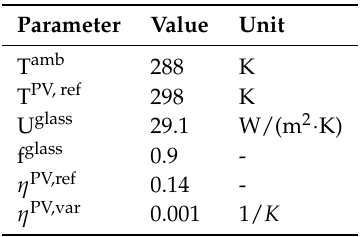
Table A7. Parameters for PV